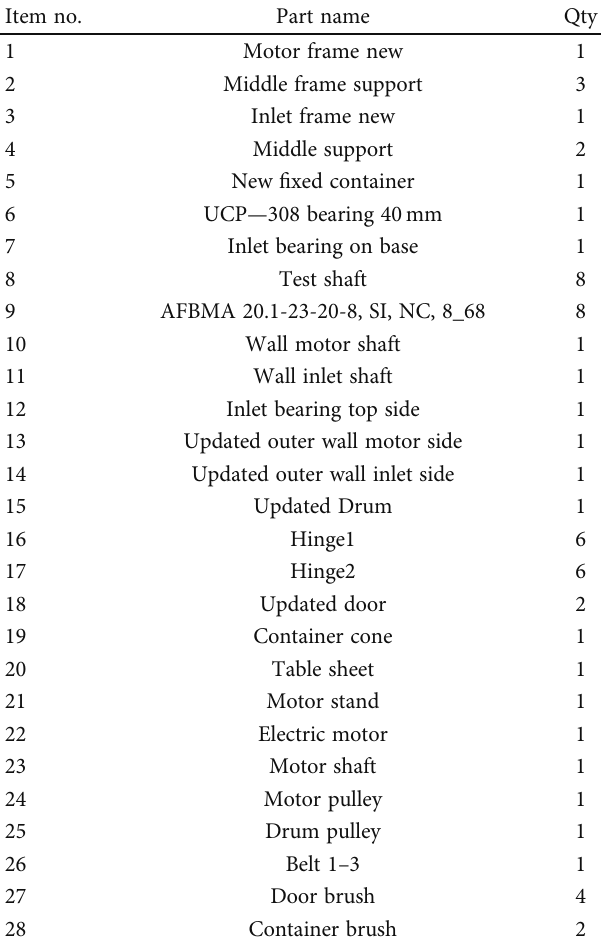
Table 7: Bill of